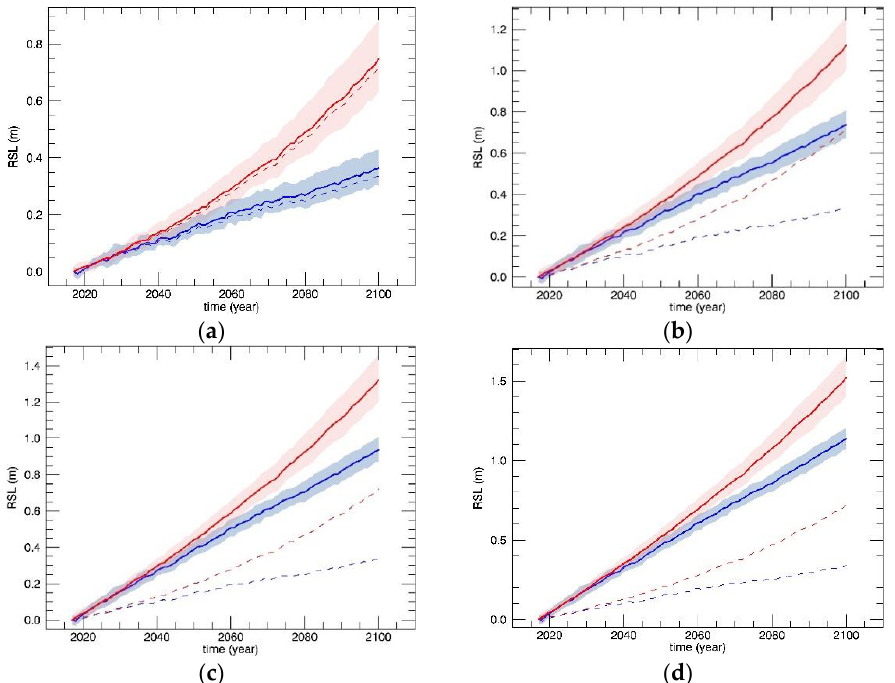
Figure 9. Sea-level projections relative to 2016 AD for the coast of South-eastern Sicily obtained by combining the IPCC-SROCC 2019 projections at regional scales with the contribution of the most common rates of land subsidence as derived from InSAR analysis (Figures 10–15): ( a ) 0.7 ± 0.35 mm/year; ( b ) 5.2 ± 2.5 mm/year; ( c ) 7.6 ± 2.5 mm/year and ( d ) 10 ± 2.5 mm/year. Full lines correspond to the 2.6 (blue) and 8.5 (red) SROCC scenarios and the coloured bands highlight the 90% confidence interval. Dashed lines correspond to the raw SROCC projections when no measured vertical land motion is included. The small-scale variations observed in the data are related to the ocean component contribution accounting for the effects of dynamic SSH, the global thermosteric SSH anomaly and inverse barometer effects. Table 1. Relative sea-levels projections for RCP 2.6 and RCP 8.5 scenarios for 2050 and 2100 with respect to 2016, for different VLM rates observed in this study in south-eastern Sicily. Uncertain- ties define the 90% confidence limits. Different cases are considered for: (i) null vertical land mo- tion (only the contribution of GIA already included in the SROCC projections is considered); (ii) mean VLM at −0.7 ± 0.35 mm/yr derived by GNSS data and (iii) observed values of VLM estimated by InSAR analysis along the coastal zones reported in Figure 5.